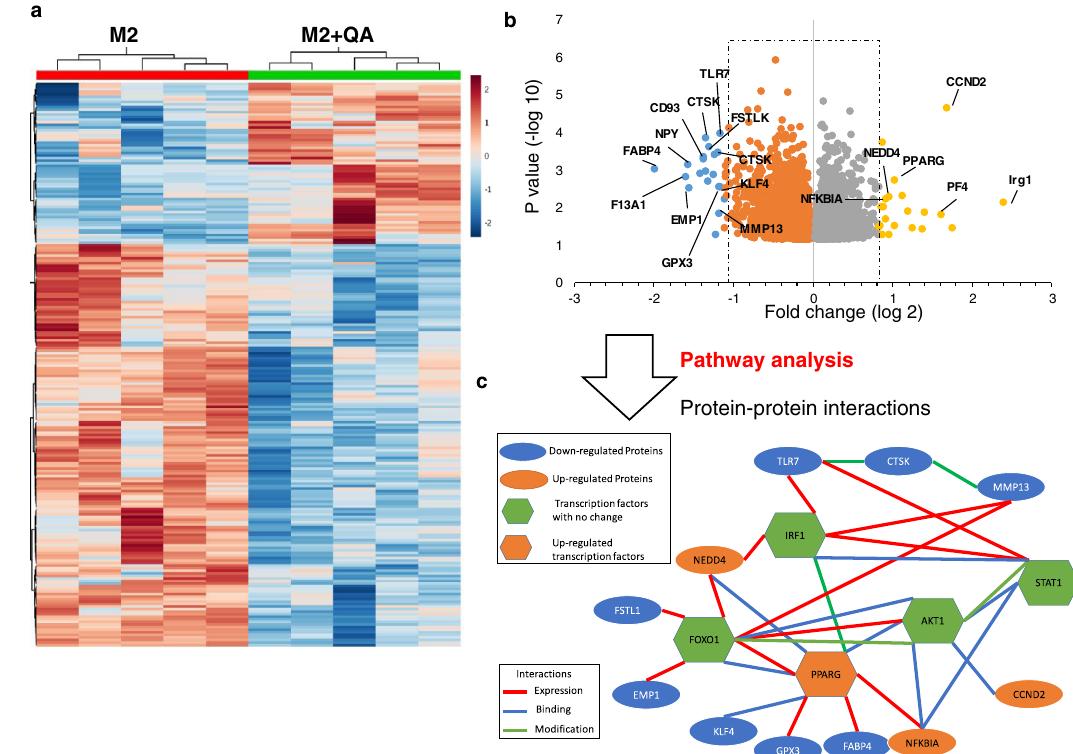
Fig. 4 | QA modulates PPAR γ mediated transcriptional programs in M2 mac- rophages. M2 macrophages cultured in presence or absence of QA (20 µ M) were fl ow-sorted for M2 macrophages (CD45+CD11b+F4/80+CD206+), and mRNA analyzed using Affymetrix arrays (Clariom ™ D Assay, mouse; n =5 biologically independent samples/group). a Heatmap demonstrates differentially expressed